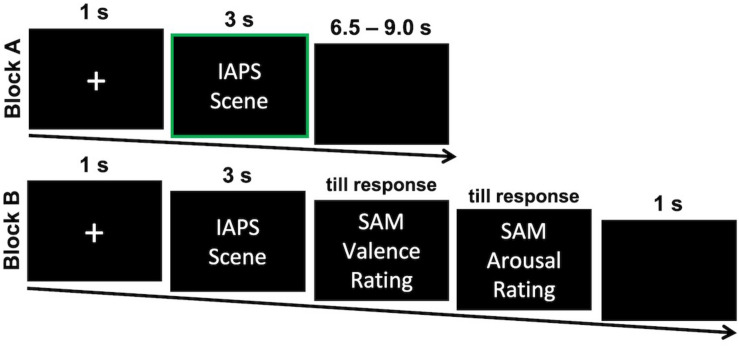
One exemplary trail for each of the two experimental blocks. Participants attentively viewed the presented IAPS scenes in Block A first and responded to self-report scales for each scene Block B afterward. EMG, SC, and FR measurements were analyzed in response to the presentation in Block A as indicated by a green frame. IAPS, International Affective Picture System; SAM = Self-Assessment Manikin.